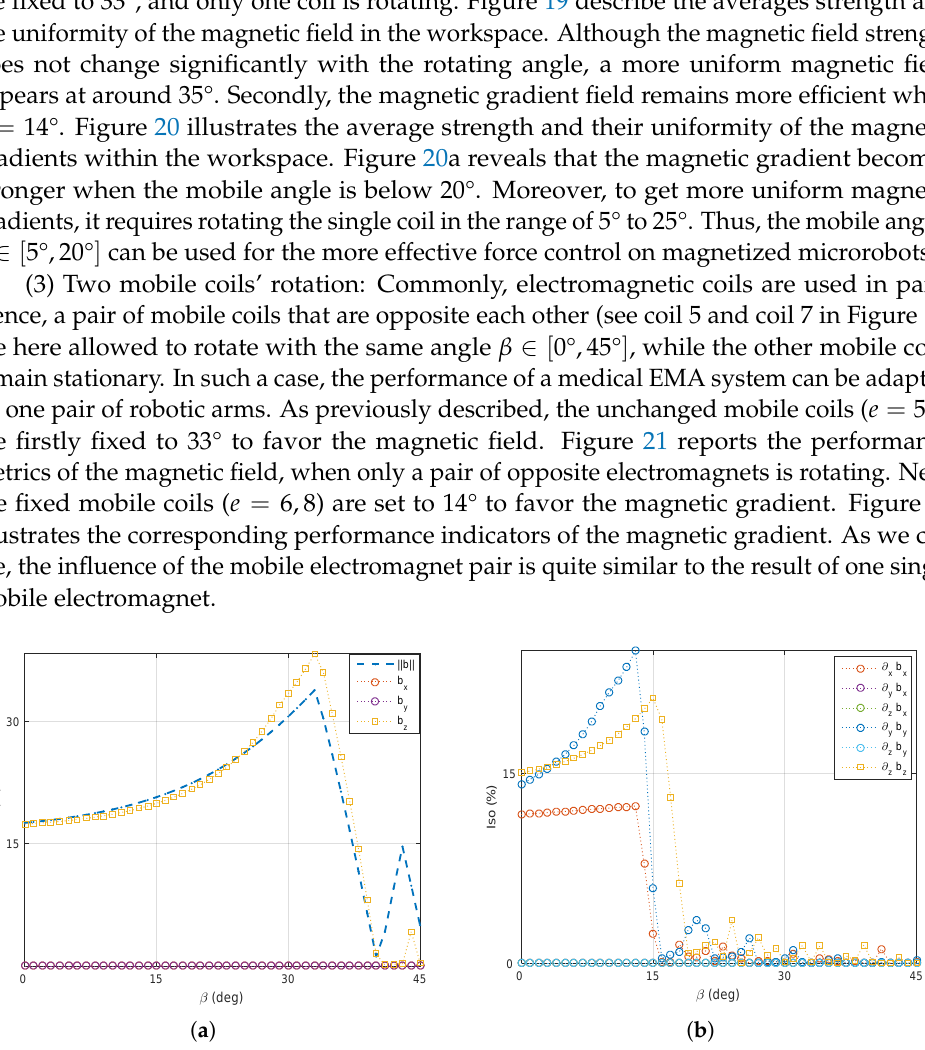
Figure 18. The uniformity γ ( ϕ ) of ( a ) magnetic fields and ( b ) its magnetic gradients with four moving electromagnets rotating with angle β ∈ [ 0°,45° ] .